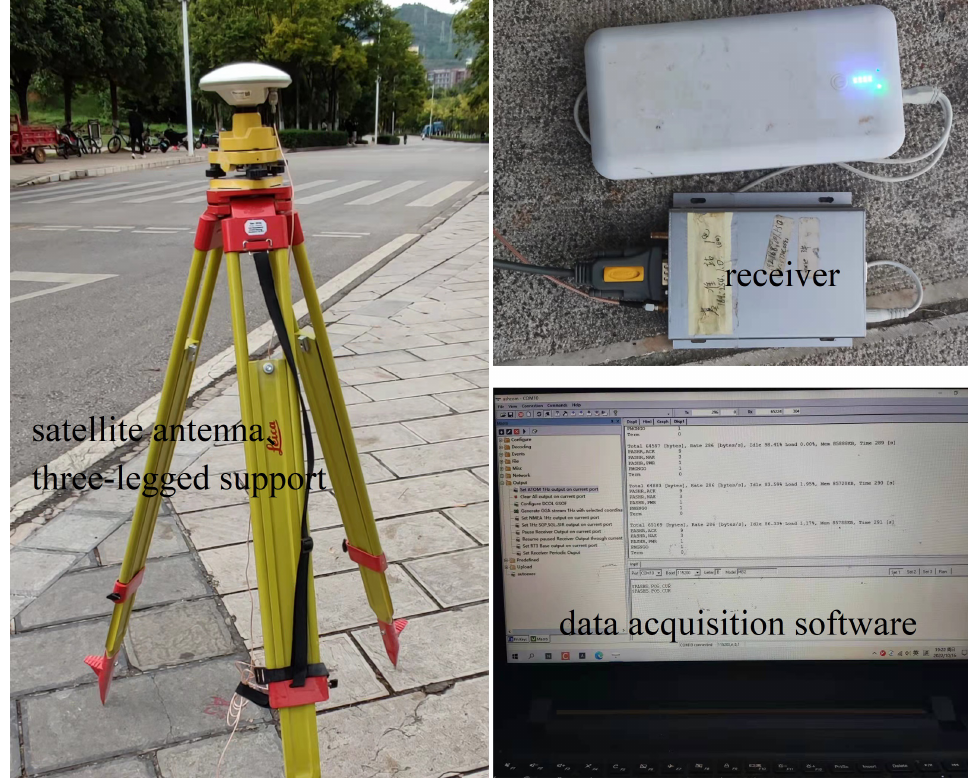
Figure 2. Data acquisition